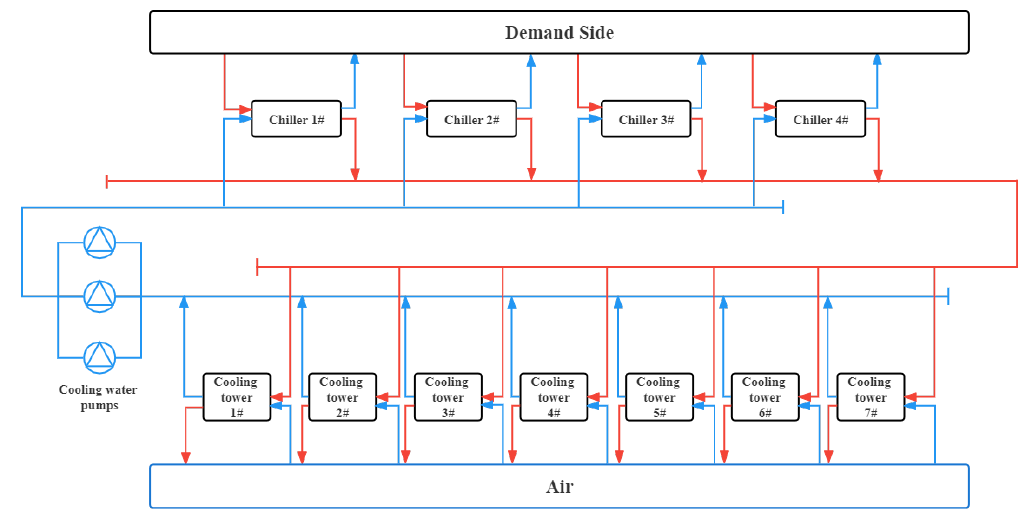
Figure 3. The layout of the cooling water system.